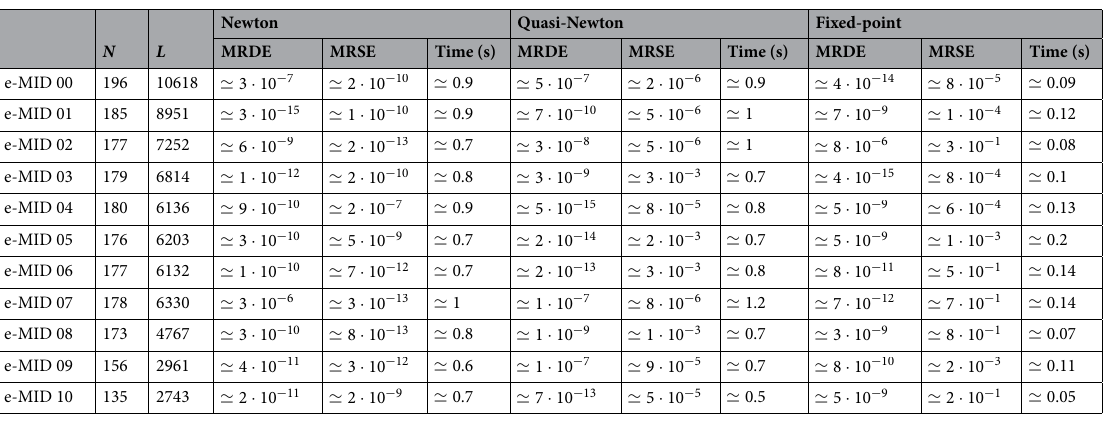
Table 7. Performance of Newton’s, quasi-Newton and the fixed-point algorithm to solve the system of equations defining the (directed version of the) CReM, on a set of real-world WDNs. All algorithms stop 8 L ( 10 θ) because the condition is satisfied. For what concerns accuracy, the two most accurate 2 − � ||∇ || ≤ methods are Newton’s and the quasi-Newton one; for what concerns speed, the fastest method is the fixed- point one. Only the results corresponding to the best choice of initial conditions are